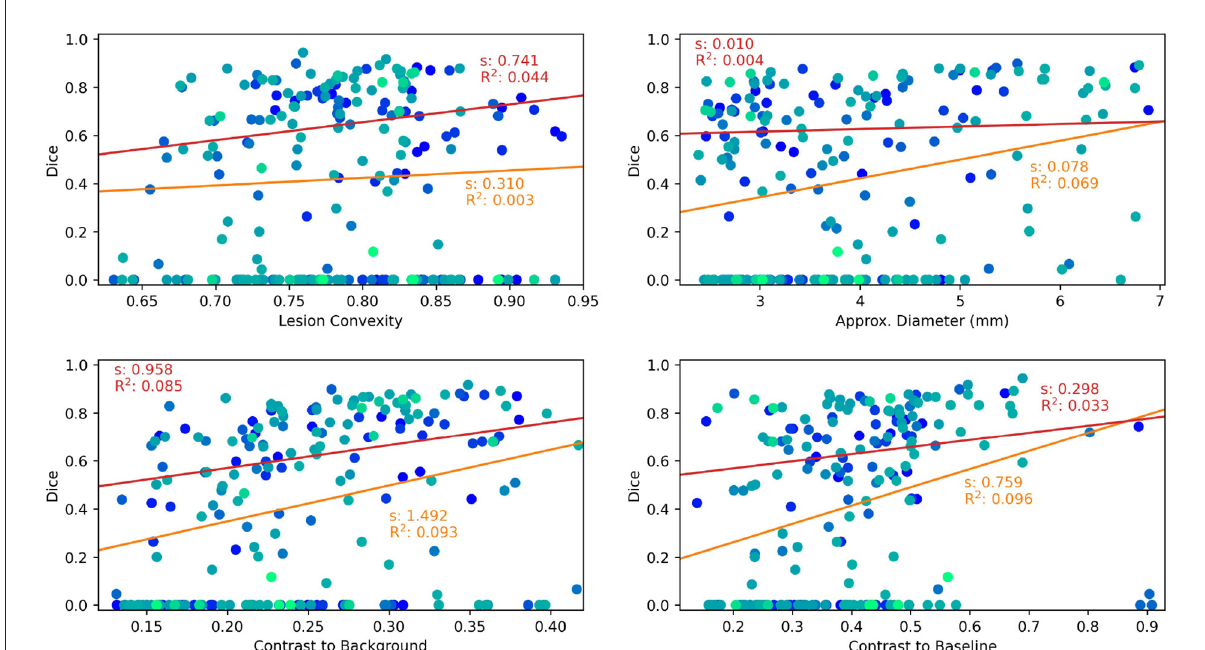
FIGURE3 Lesion characteristics influencing the lesion detection and segmentation performance of ANCR-Net. Different colors represent different patients. The results of a linear regression measuring the influence of the respective lesion characteristic on Dice score are shown. Red lines show the results using only those lesions detected by ANCR-Net, whereas orange lines show the results considering all lesions. For each regression line, the slope s and the R 2 value are